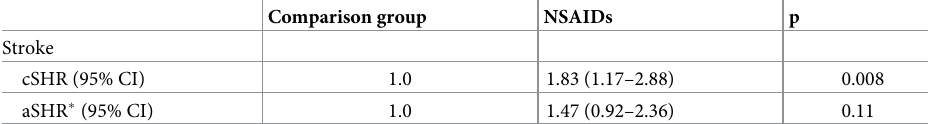
Table 4. Subhazard ratios of stroke based on the comparison linked-risk regression.